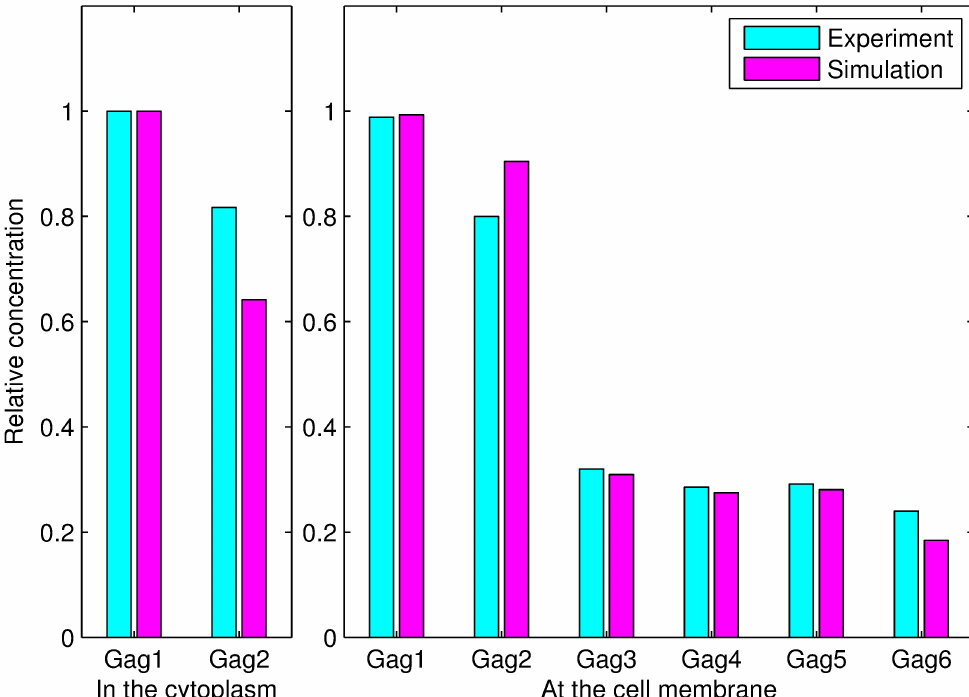
Fig 7. Comparison between the simulation results and experimental data for Gag-dCTD. Gagi ( i = 1, 2, (cid:1)(cid:1)(cid:1) , 6) denotesa polymerwith i monomers.The subfigureon the left side illustrates the comparisons betweenthe simulationand experiment concentrations for monomers and dimers in the cytoplasm. The subfigure on the right side shows the differences betweenthe simulationand experiment concentrations for the six types of polymers at the plasma membrane. The concentration of each polymer was normalized by dividingby the concentration of Gag monomerin the cytoplasm.